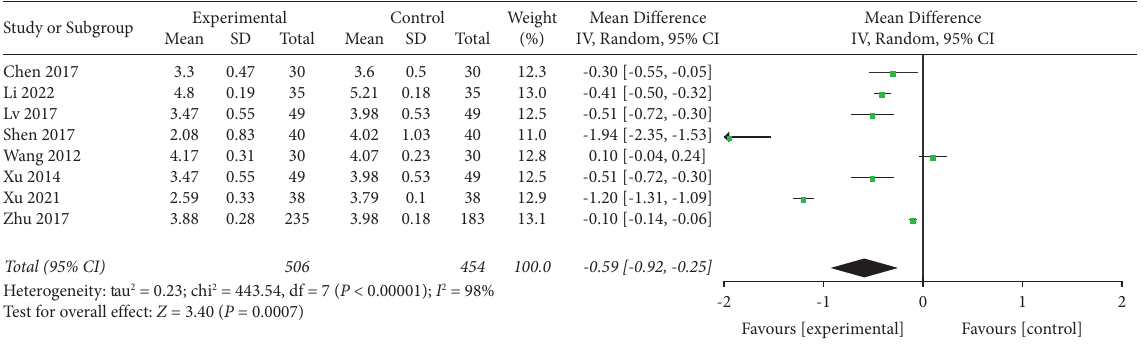
Figure 5: Comparison of the VAS at 24h between the AA group and the control